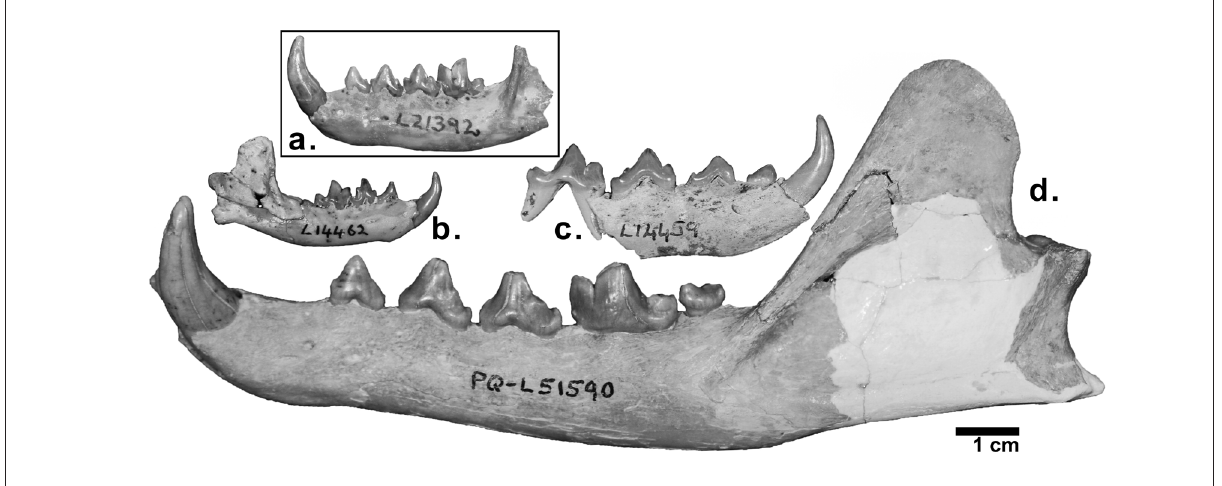
Figure 2: Representative of Langebaanweg (a) Herpestidae (PQ-L 21392) and (b–d) Viverridae (b: PQ-L 14462, c: PQ-L 14459, d: PQ-L